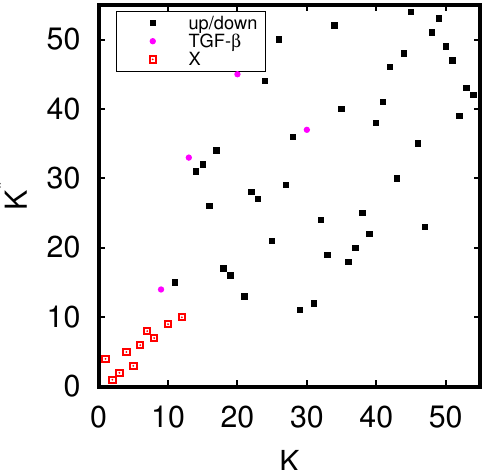
Figure A1. Positions of the 54 proteins of Table 1 in the local PageRank–CheiRank. Note that these positions are identical to the positions of Figure 7 and the corresponding K , K ∗ values are given in the 3rd and 4th column of Table 1. Pink full circles correspond to the subgroup of TGF- β nodes, full black boxes correspond to the subgroups of up- and down-proteins and red squares correspond to the subgroup of X-proteins.